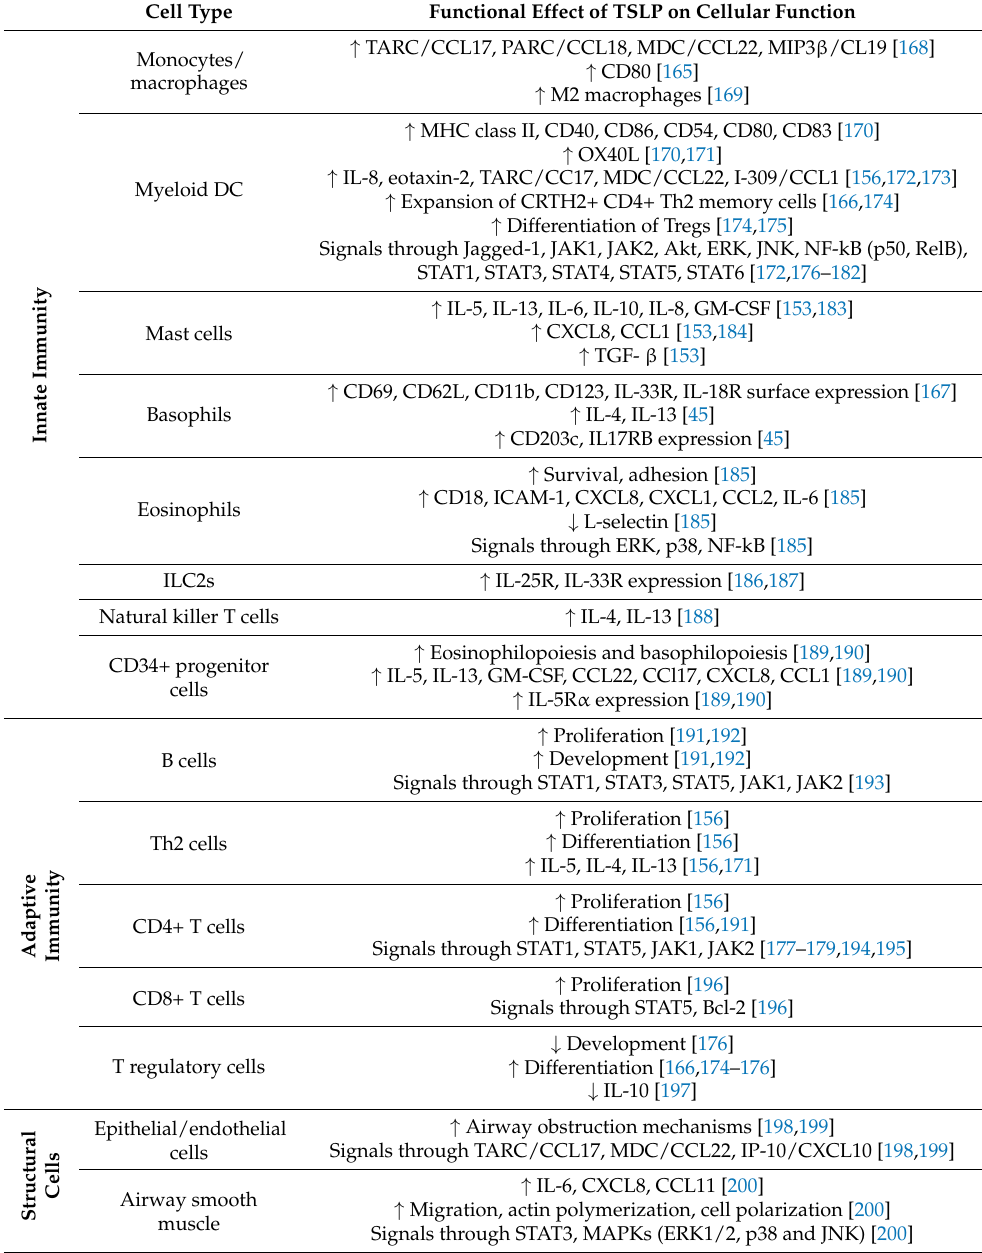
Table 3. TSLP and pathogenic effects in asthmatic